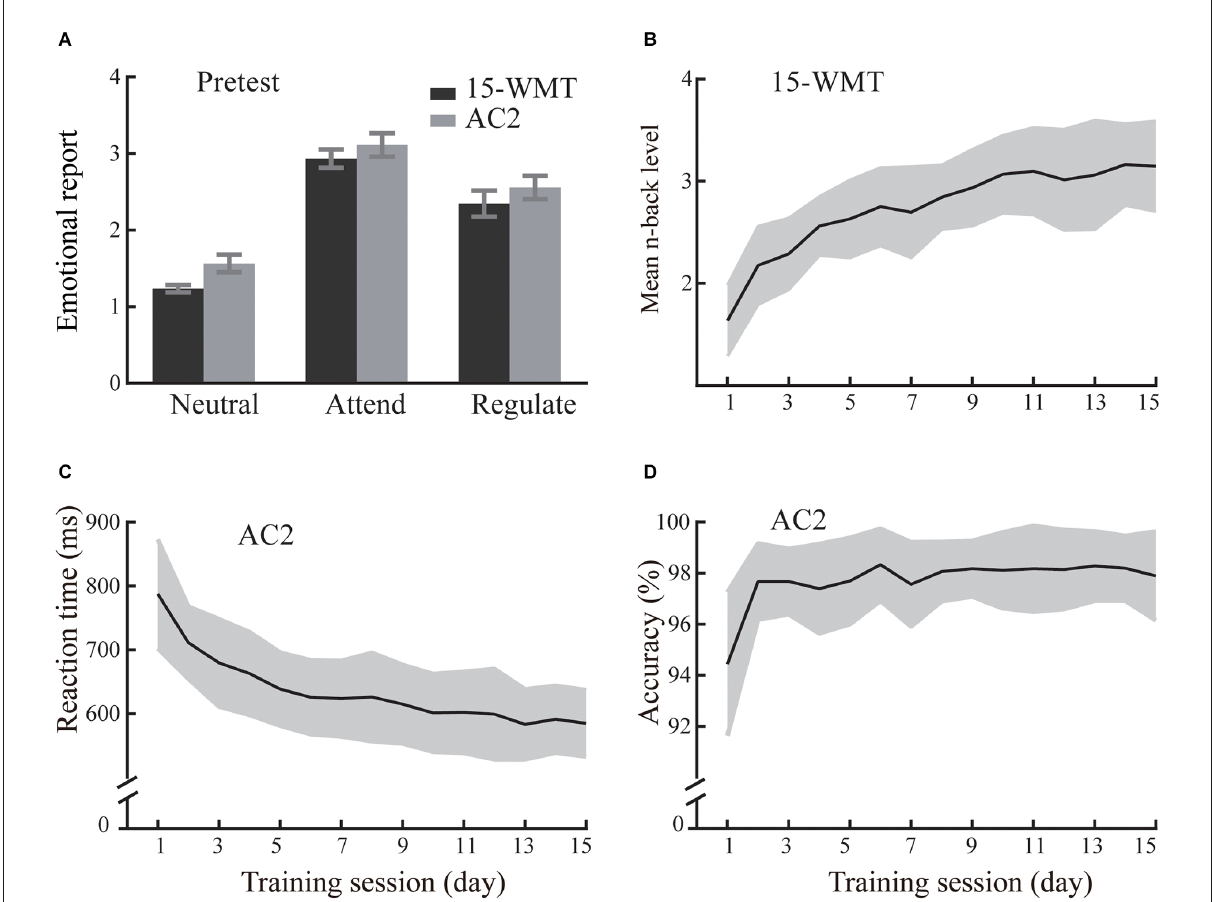
FIGURE4 The emotional reports and training performance of the 15-day WM training group (15-WMT) and active control group (AC2) in Experiment 2. The mean emotional reports and error bars for three conditions at the pretest (A) . Training-related changes in the 15-WMT (B) and AC2 (C,D) . Shading indicates standard deviation.